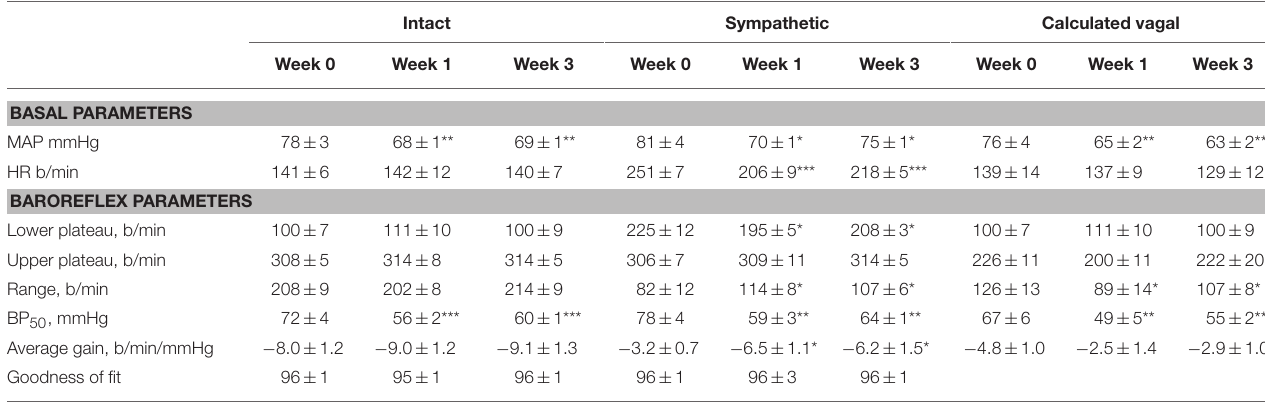
TABLE 1 | Average basal values and baroreflex parameters describing intact, sympathetic and calculated vagal MAP-HR curves before and at weeks 1 and 3 of subcutaneous administration of moxonidine ( n = 6).